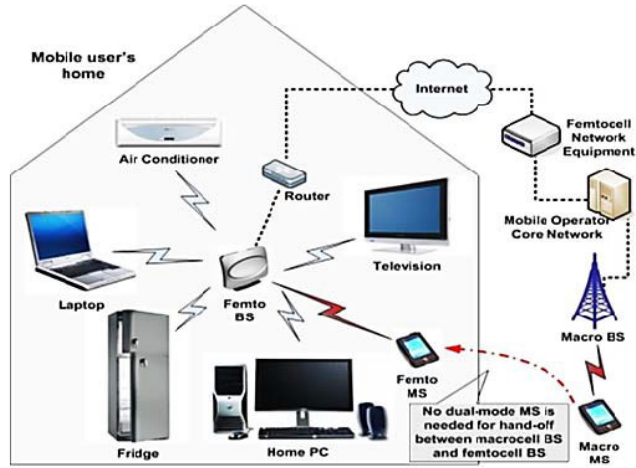
Fig. 1: Femtocell in a home setting